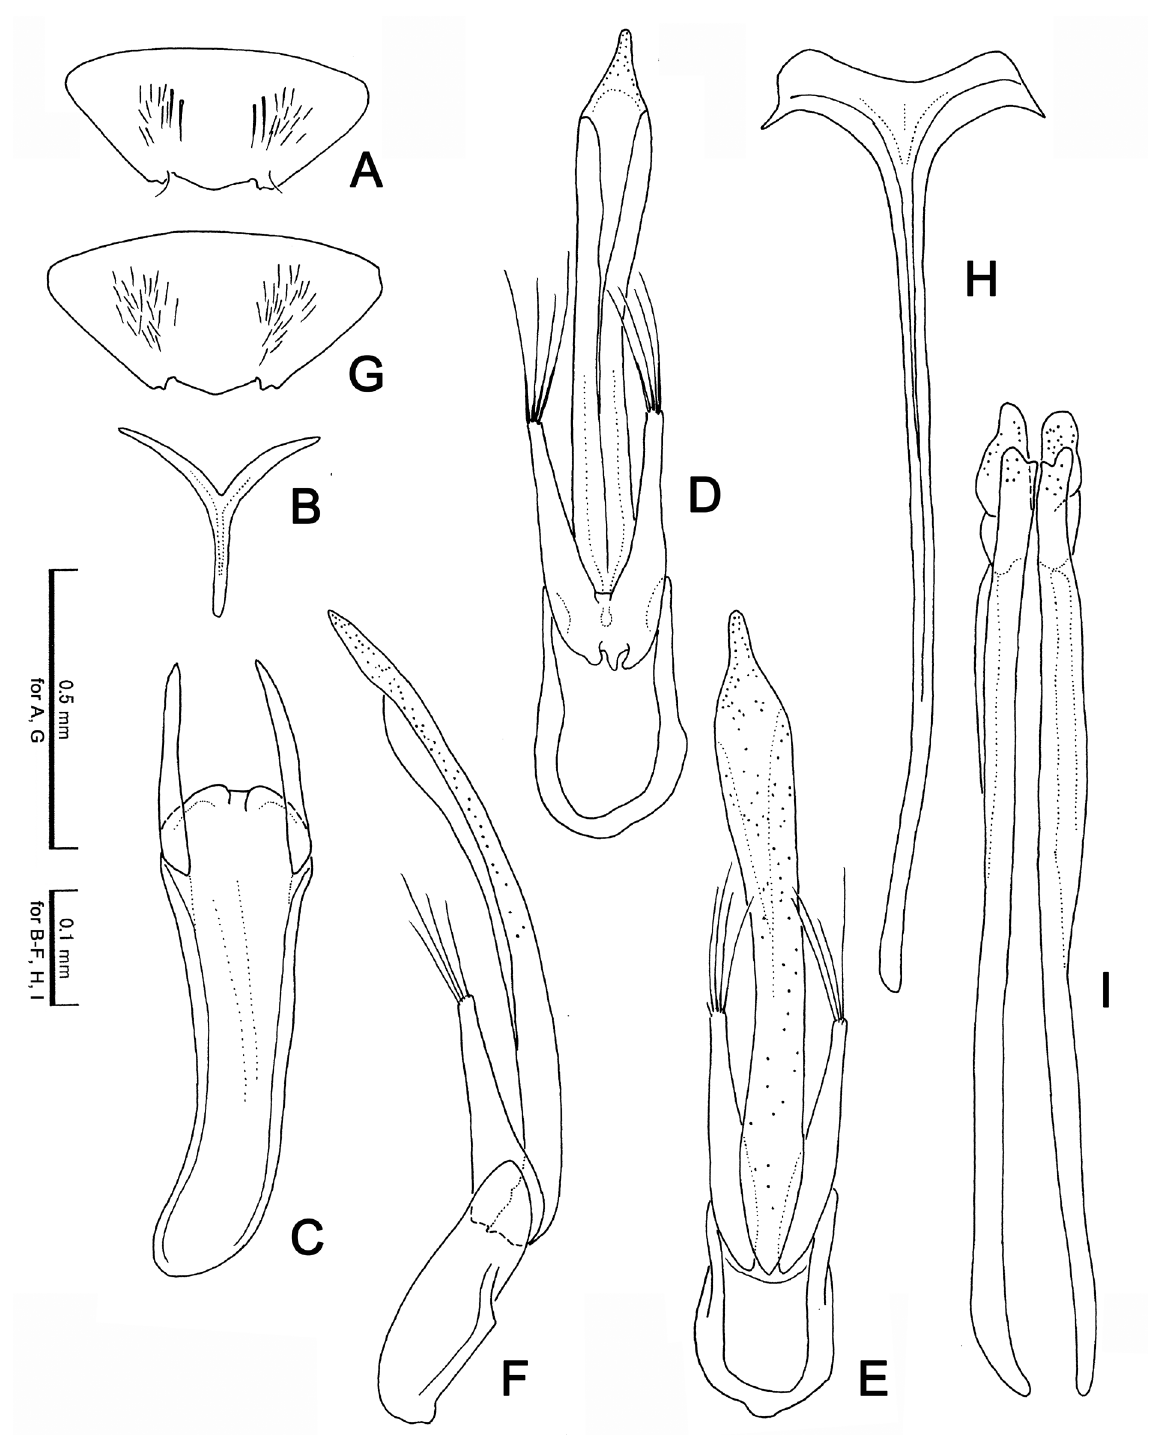
Fig. 16. Mexico borneensis sp. nov., male (A–F) and female (G–I) genitalia (holotype and paratype, BPBM). A, G . Sternite VII. B . Sternite VIII. C . Sternite IX. D . Aedeagus, ventral view. E . Aedeagus in dorsal view. F . Aedeagus in right lateral view. H . Urosternite. I